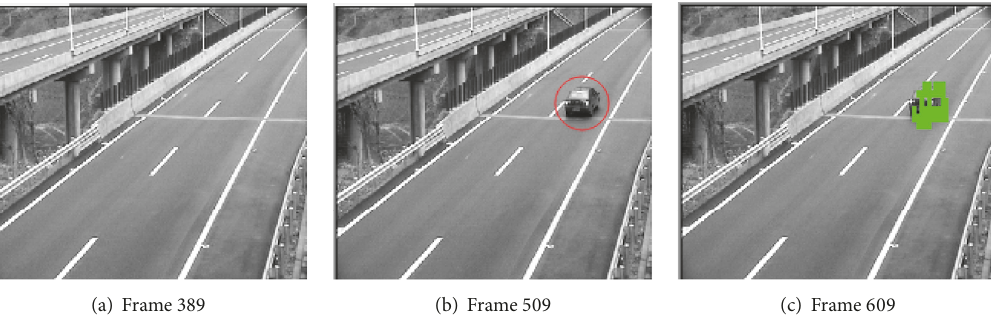
Figure 7: Test results of parking on Chongqing Expressway.